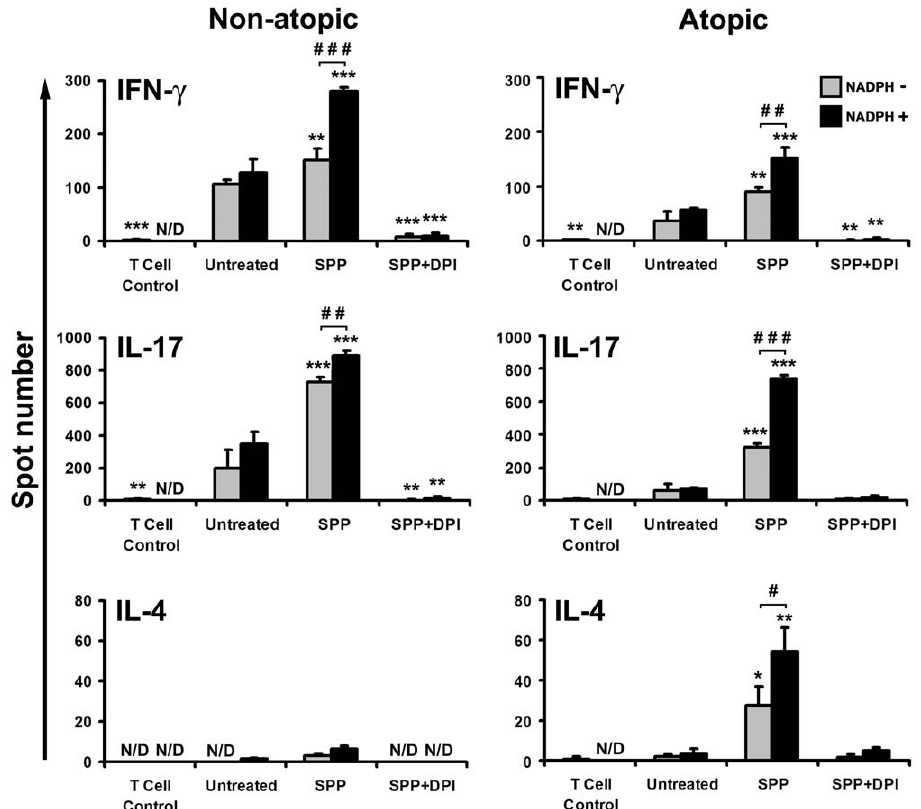
Figure 7. Cytokine production of CD3 + pan-T cells in response to co-culture with SPP-exposed human moDCs. Freshly isolated CD3 + pan-T cells obtained from three ragweed allergic individuals and three non-allergic ones were co-cultured with allogeneic moDCs pre-treated with SPPs for 4 days under various conditions as indicated on the figure. The numbers of IFN- c -, IL-17-, and IL-4-producing T cells were detected by ELISPOT assays. Each assay was performed three times per donor, and data from one representative experiment are shown. Data are presented as means 6 SEM. * p , 0.05, ** p , 0.01, *** p , 0.001 vs untreated DCs, # p , 0.05, ## p , 0.01, ### p , 0.001. (DPI: diphenyleneiodonium; N/D: not detectable; SPP: subpollen particle).